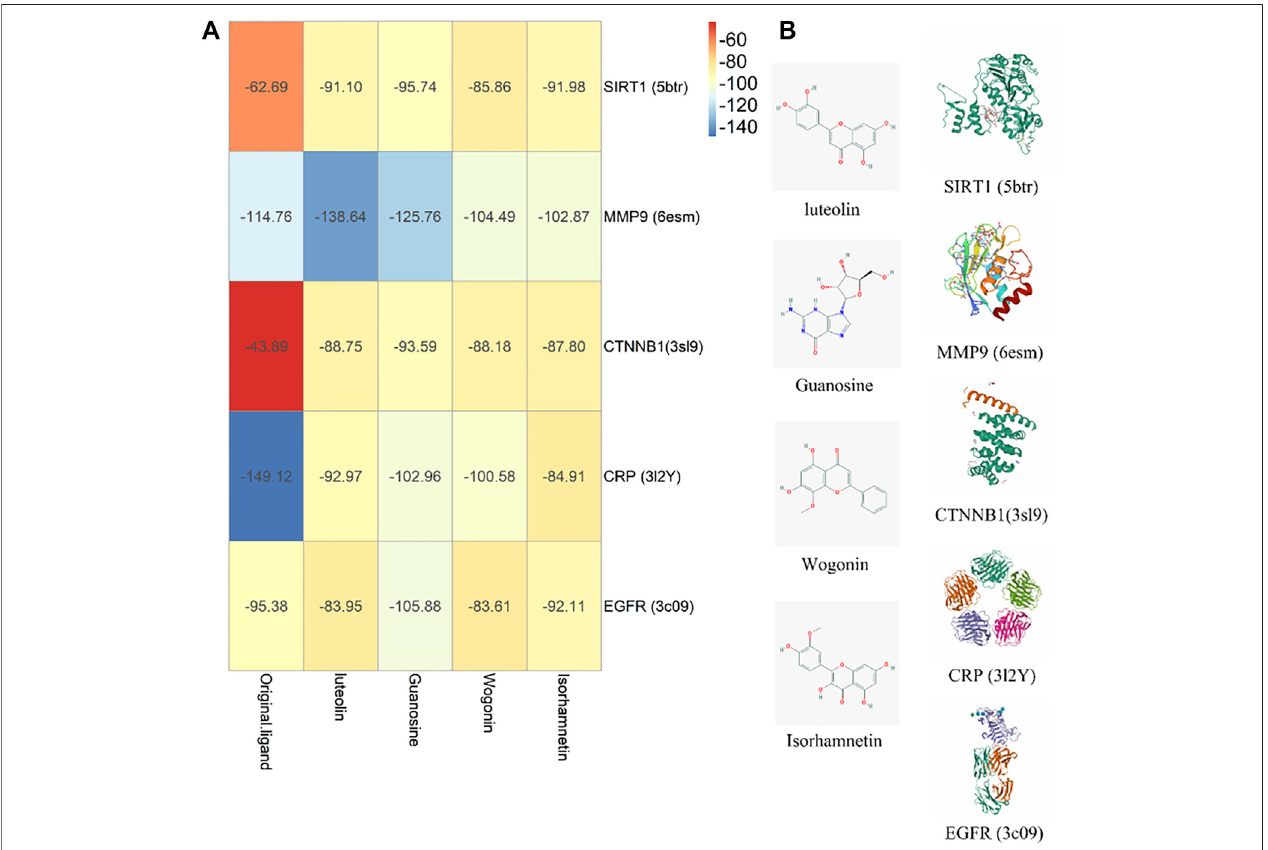
FIGURE 9 | Molecule docking veri fi cation diagram. (A) Component-target af fi nity energy heat map, the greater the absolute value of kJ/mol, the stronger the binding energy. (B) Molecule docking